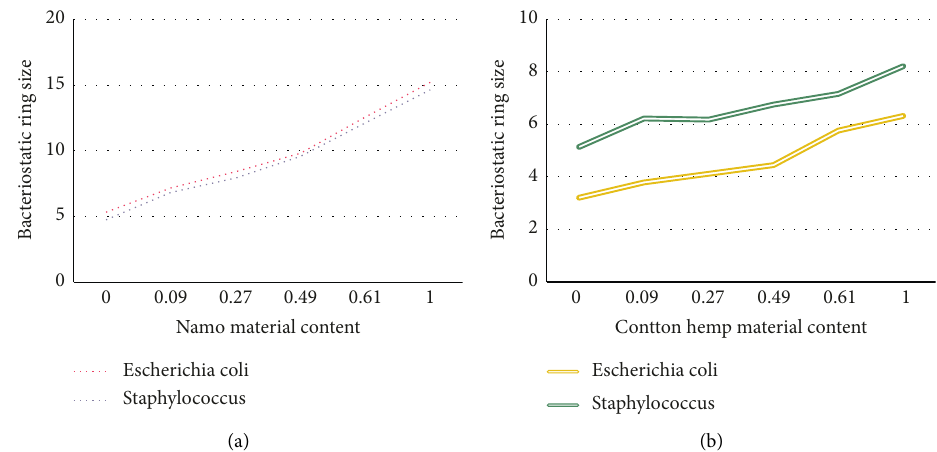
Figure 7: Bacteriostatic ring size test. (a) The test result of the antibacterial ring of the experimental group. (b) The test results of the control group’s antibacterial ring.